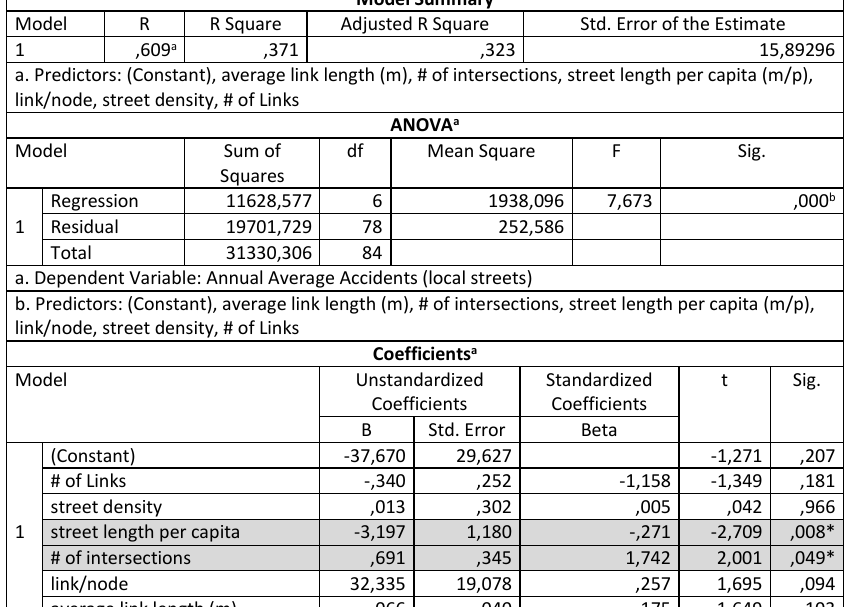
Table 2 Model 2 Regression Results (Stage 2, Model summary, ANOVA and Coefficients) Model Summary